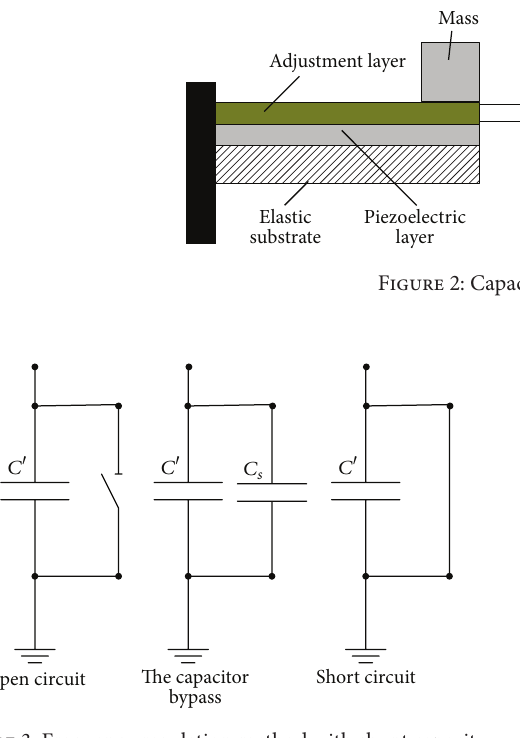
Figure 3: Frequency regulation method with shunt